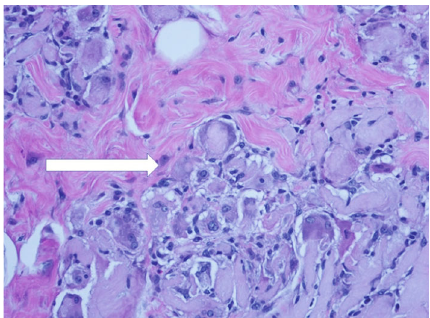
Figure 5: Gel with associated giant cell granulomatous response (arrow). H and E stain × 40.